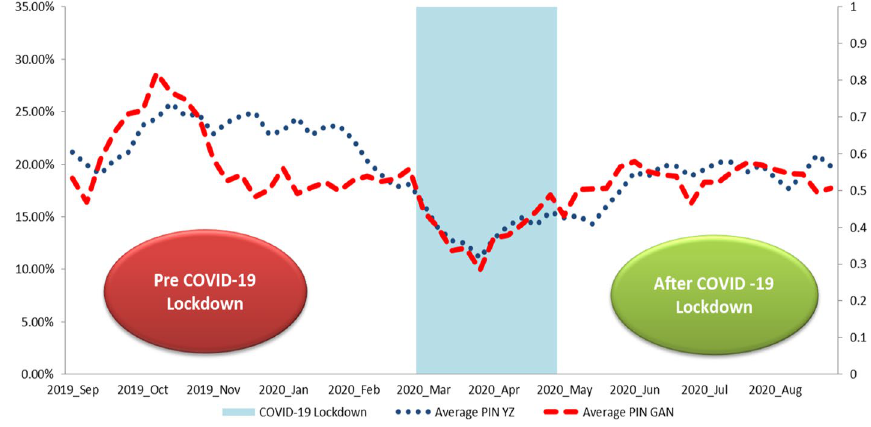
Fig. 2 Average PIN: YZ (Yan and Zhang 2012) versus GAN (Gan et al.